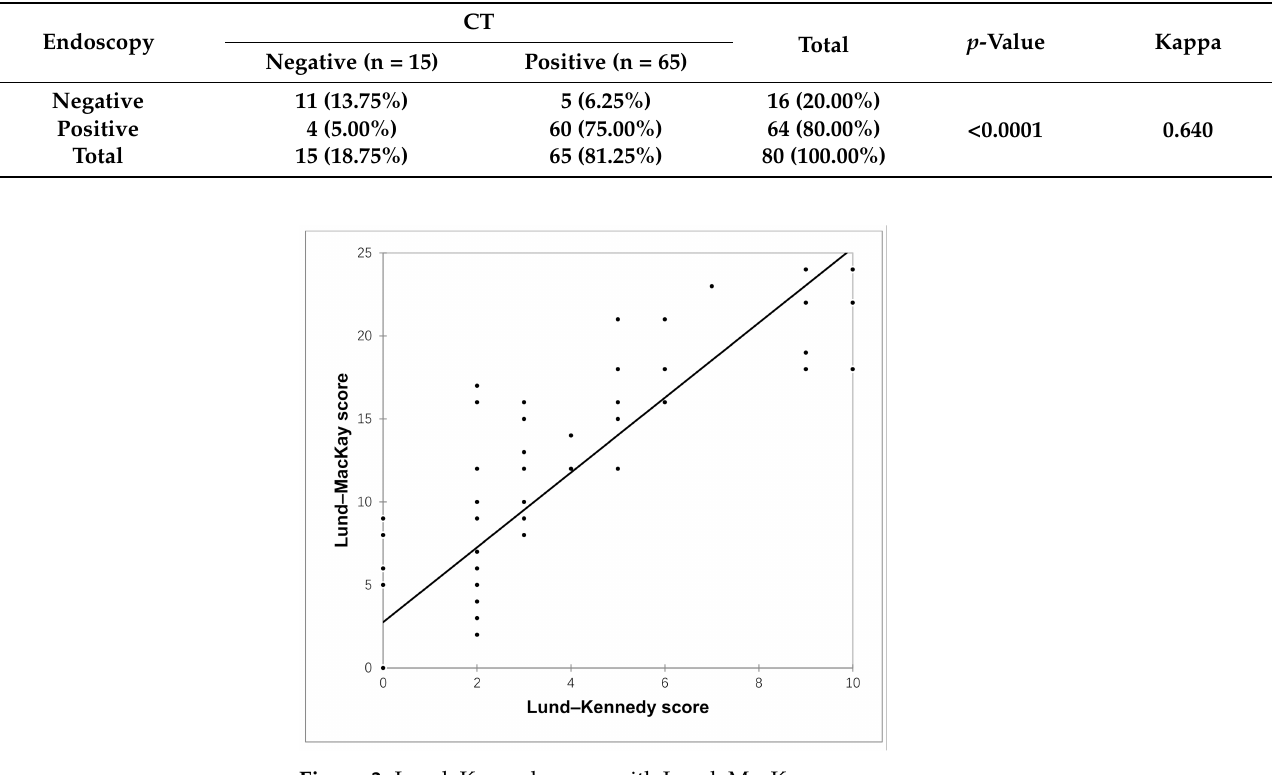
Figure 3. Lund–Kennedy score with Lund–MacKay